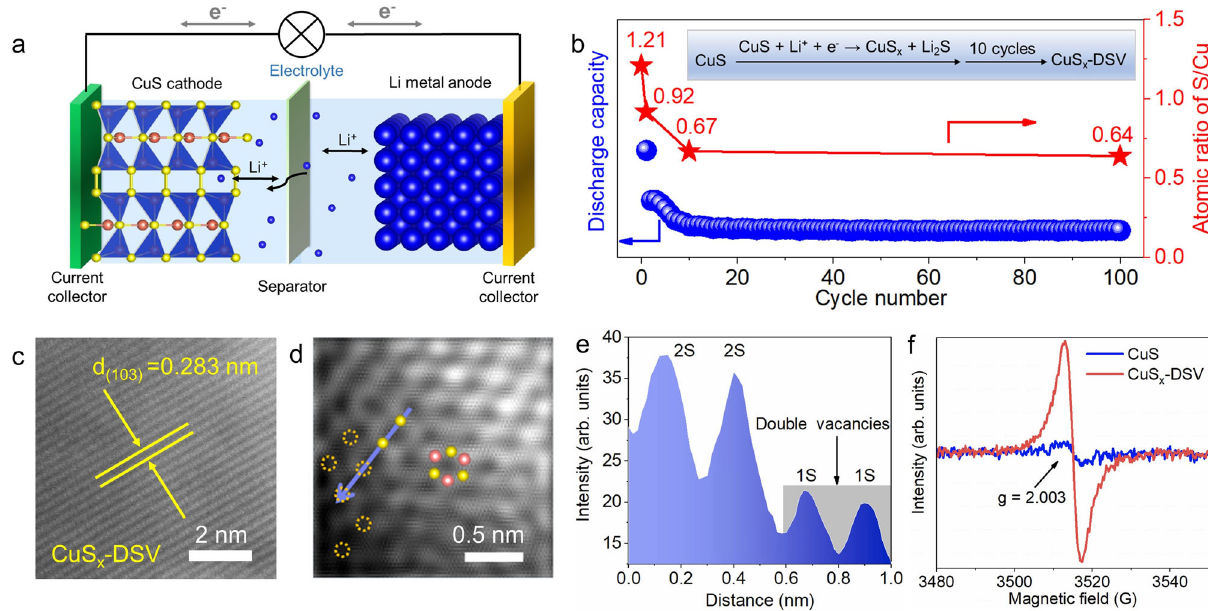
Fig. 2 Lithium electrochemical tuning method and structural characterizations. a Schematic diagram of lithium-ion battery assembled with CuS (cathode) and Li metal (anode). b Discharge capacity of CuS (blue dots) and the atomic ratio of S/Cu (red stars) with respect to the cycle number at a constant current of 0.044 mA·cm -2 in the voltage range of 0.01 – 3 V. Sulfur atoms in the CuS lattice were controllably taken away to form Li 2 S, resulting in CuS x -DSV. c Spherical aberration corrected HRTEM, d HAADF-STEM image, and e corresponding intensity pro fi les extracted from the blue line of CuS x -DSV in d . The typical lattice arrangement of hexagonal phase CuS was presented by the higher contrast of Cu and the lower contrast of sulfur atoms. The intensity of lower left sulfur atoms was around 20 units, almost half of S atoms (~ 40 unit), suggesting the absence of single sulfur atoms. The pink, yellow spheres, and yellow dashed circles indicate copper, sulfur atoms, and sulfur vacancies, respectively. f ESR spectra of CuS (blue curve) and CuS x -DSV (red